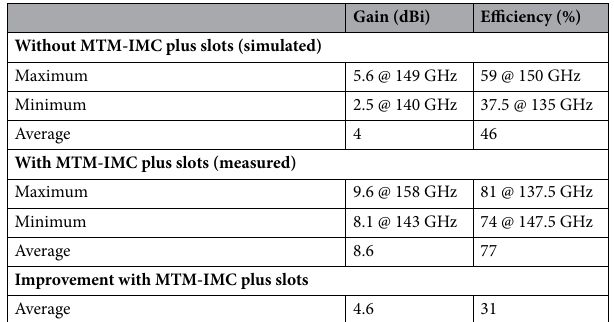
Table 2. Radiation characteristics.